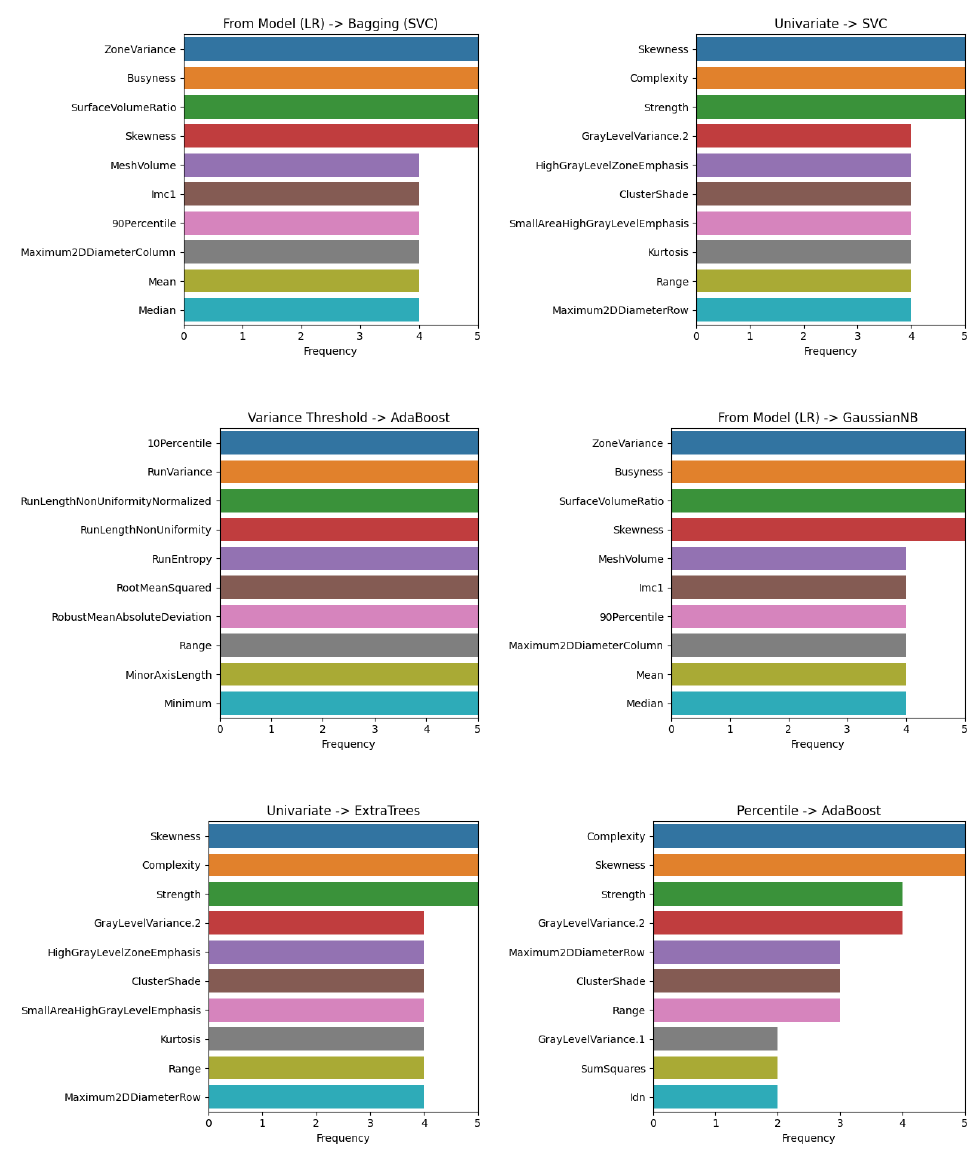
Figure 7. Selected features